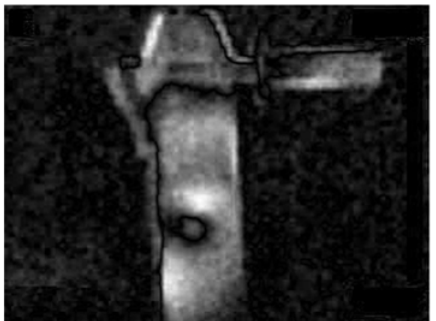
Figure 8. Difference of thermal images: | hag ‐ ag1b| , where hag − matrix (320 × 240) of the thermal image of the healthy angle grinder, ag1b − matrix (320 × 240) of the thermal image of the angle grinder with 1 blocked air inlet.